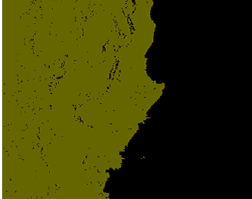
Figure 7. Extracted land and water clusters ( green: land surface, black: water